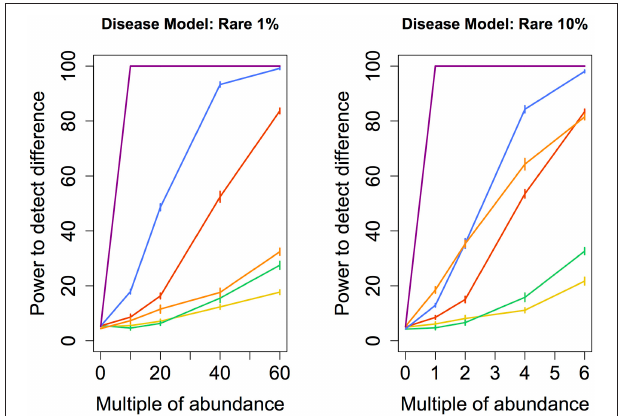
FIGURE 2 | Rare disease model: power comparison of the best performing statistical techniques from each category. Bars represent standard errors of the mean. [Purple: modified metastats; Blue: Partial least squares regression (50 components); Red: principal components regression (50 components); Orange: diversity; Green: distance-based regression (Manhattan distance); Yellow: regularized regression (Lasso)].